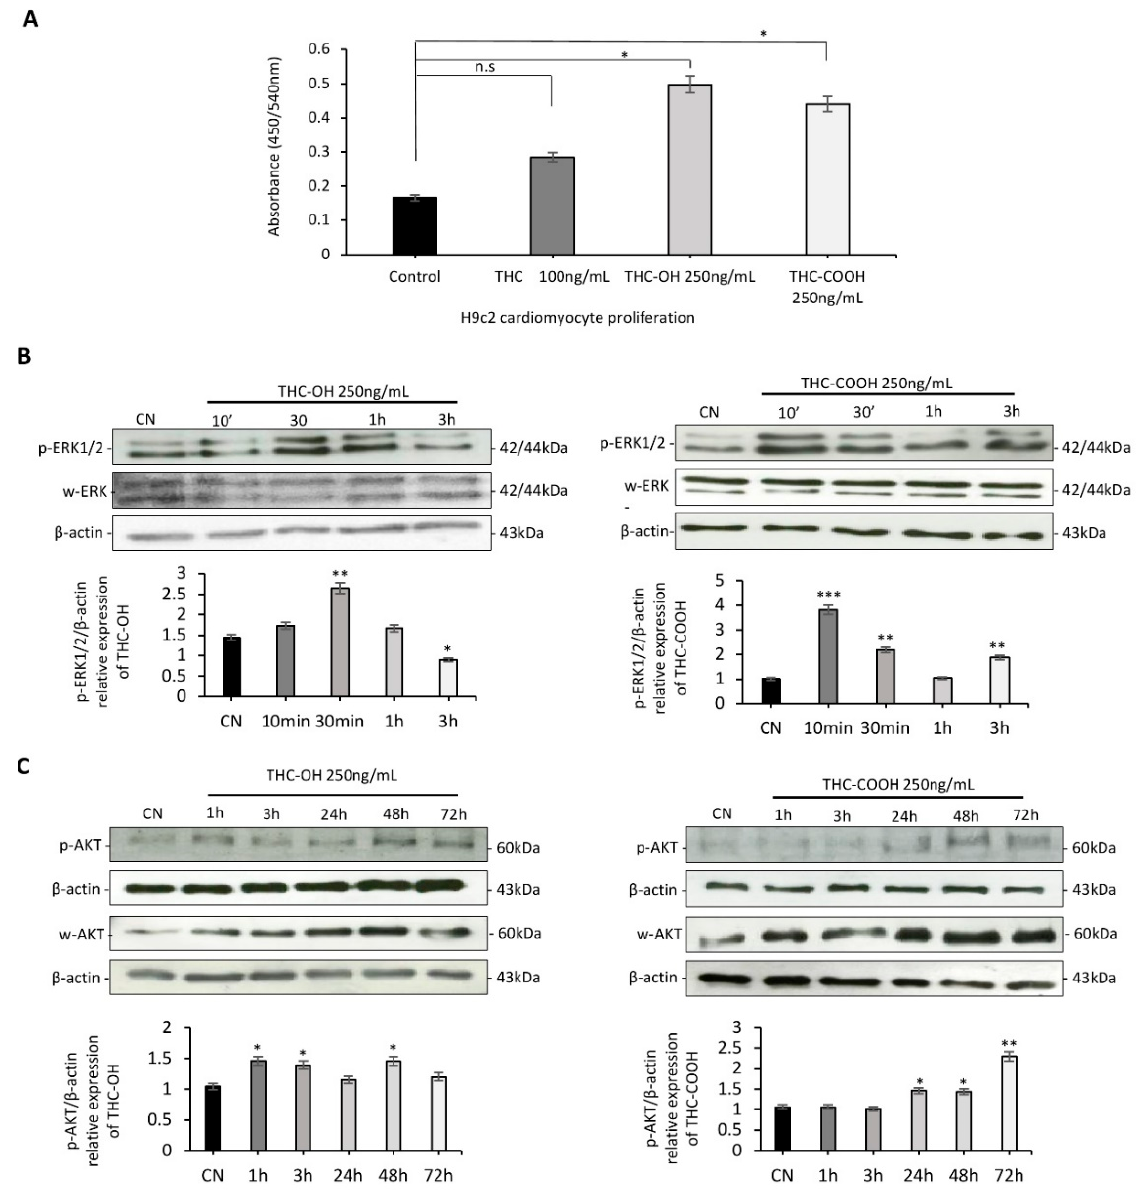
Figure 2. H9c2 changes in cell proliferation in response to cannabinoids. ( A ) H9c2 cardiomyocyte proliferation in response to THC, THC-OH and THC-COOH, represented data of five individual